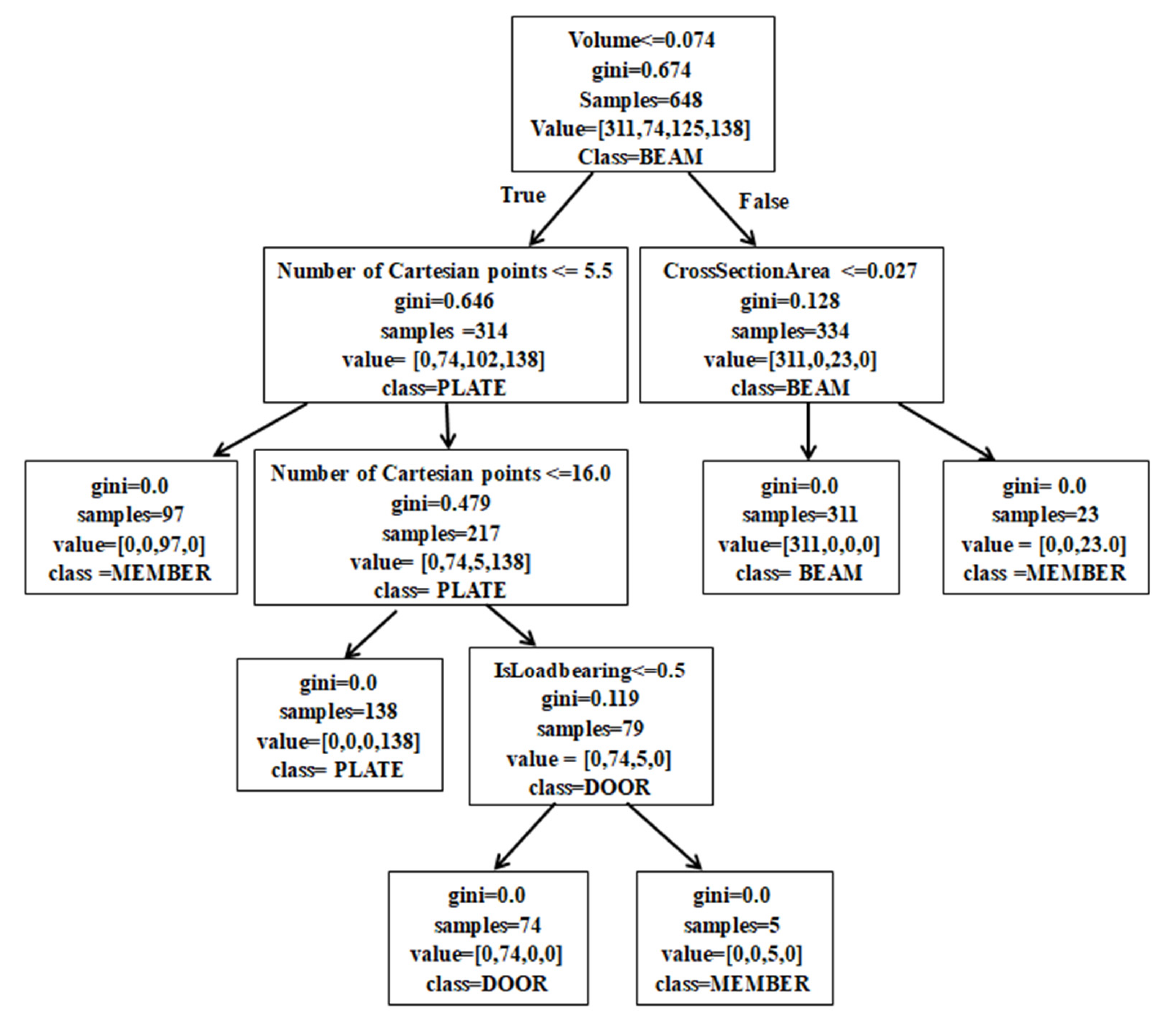
Figure 10. Decision tree results visualization.